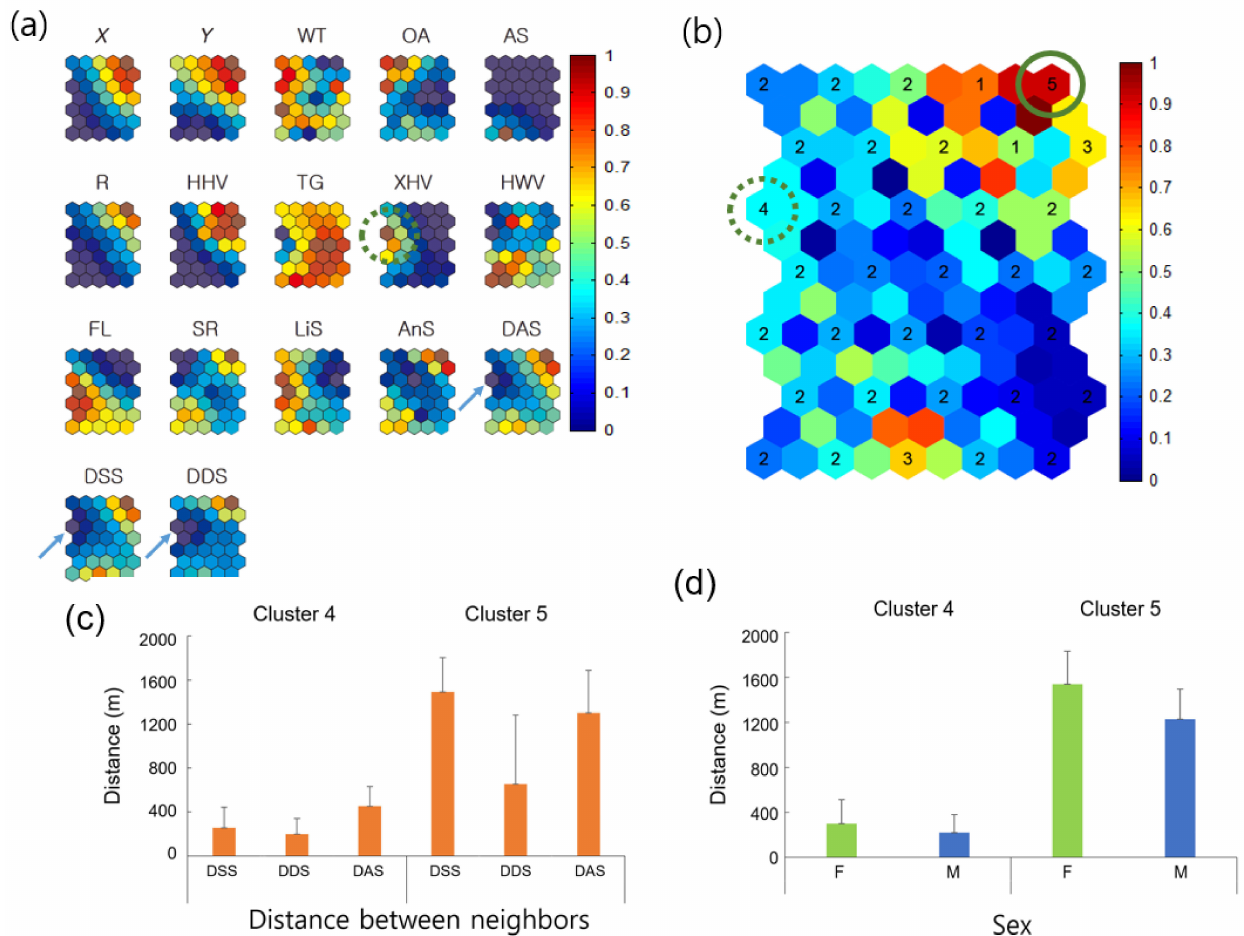
Figure 6. Association of covariates and comparison of neighbor distances for all individuals according to Geo-SOM ( k = 3). ( a ) neighbor distances in association with environmental and biological factors on the component map ( k = 3), ( b ) clustering, ( c ) nearest distances between different and same sex, and ( d ) between either females or males. Values in all component maps were normalized between 0.0 and 1.0, as shown in the vertical bar. Water temperature: WT; open area: OA; artificial structure: AS; road: R; hydric herbaceous vegetation: HHV; tall grassland: TG; xeric herbaceous vegetation: XHV; hydric woody vegetation: HWV; floating-leaved hydrophytes: FL; sex ratio: SR; linear speed: LiS; angular speed: AnS; distances between all neighbor individuals: DAS; distances be-tween neighbors with the same sex: DSS; and distances between neighbors with different sexes: DDS. Cluster 4 indicates the minimum distances between neighbors, whereas Cluster 5 provides the maximum distances according to the Geo-SOM training. Mean ± standard deviations are 255.6 ± 186.3 m, 200.5 ± 140.1 m, and 451.8 ± 179.9 m for Cluster 4 ( n = 381), and 1493.6 ± 309.8 m, 653.7 ± 630.0 m, and 1303.6 ± 383.1 m for Cluster 5 ( n = 219) for DSS, DDS, and DAS, respectively, in ( c ). Mean ± standard deviations are 299.9 ± 210.4 m ( n = 169) and 220.4 ± 155.7 m ( n = 212) for Cluster 4, and 1538.9 ± 293.8 m and 1228.8 ± 265.0 m for Cluster 5 for F and M, respectively, in ( d